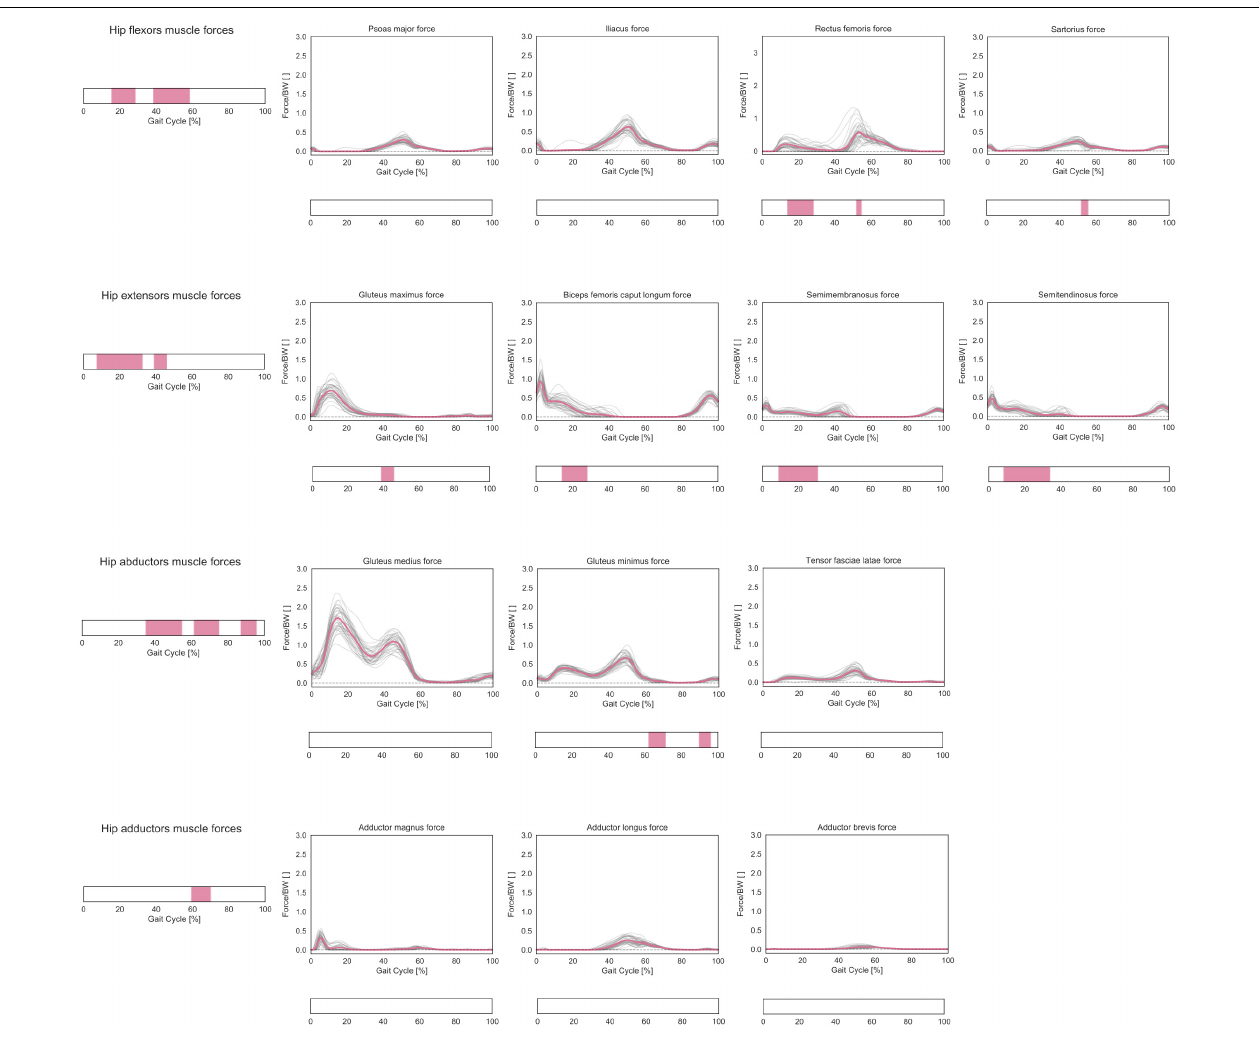
FIGURE 7 | Predicted lower-limb muscle forces during the GC. Forces are normalized by body weight (BW). Average profiles for each subject are reported in gray, while the cohort’s mean is reported in pink. Muscles were grouped according to their main function in hip extensors, hip flexors, hip abductors, and hip adductors, and the predicted muscle forces in each functional group were considered as a multidimensional vectorial field. For each muscle compartment, phases of GC in which a statistically significant correlation was observed in the SPM vector-field CCA are indicated in the leftmost panel. Below each muscle, the results of the post hoc scalar-field linear regression analyses are